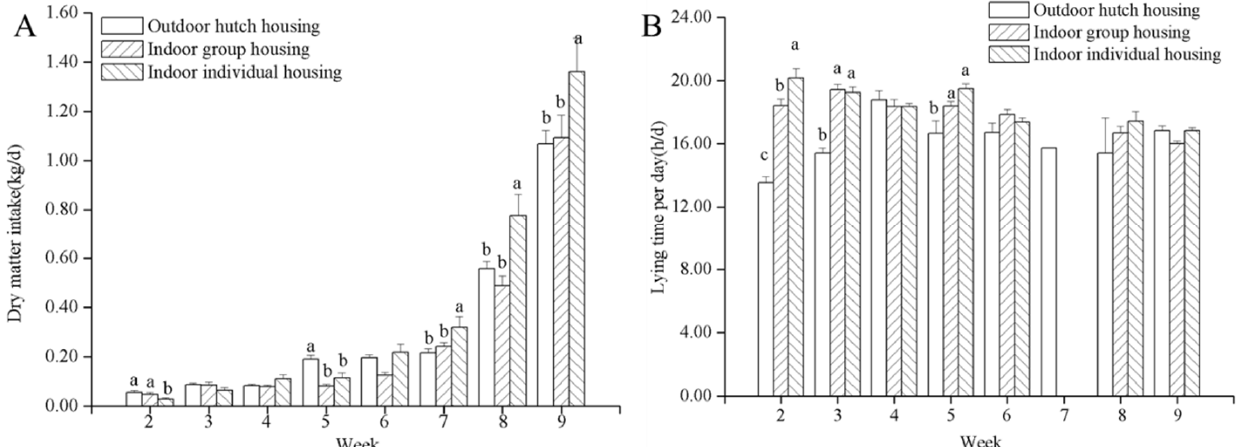
Figure 2. Relationship between ( A ) dry matter intake and ( B ) lying bouts of calves in the trial. Observations began at week 2 and ended at week 9 of age. a–c Means within a week for the rearing systems were significantly different at p < 0.05.